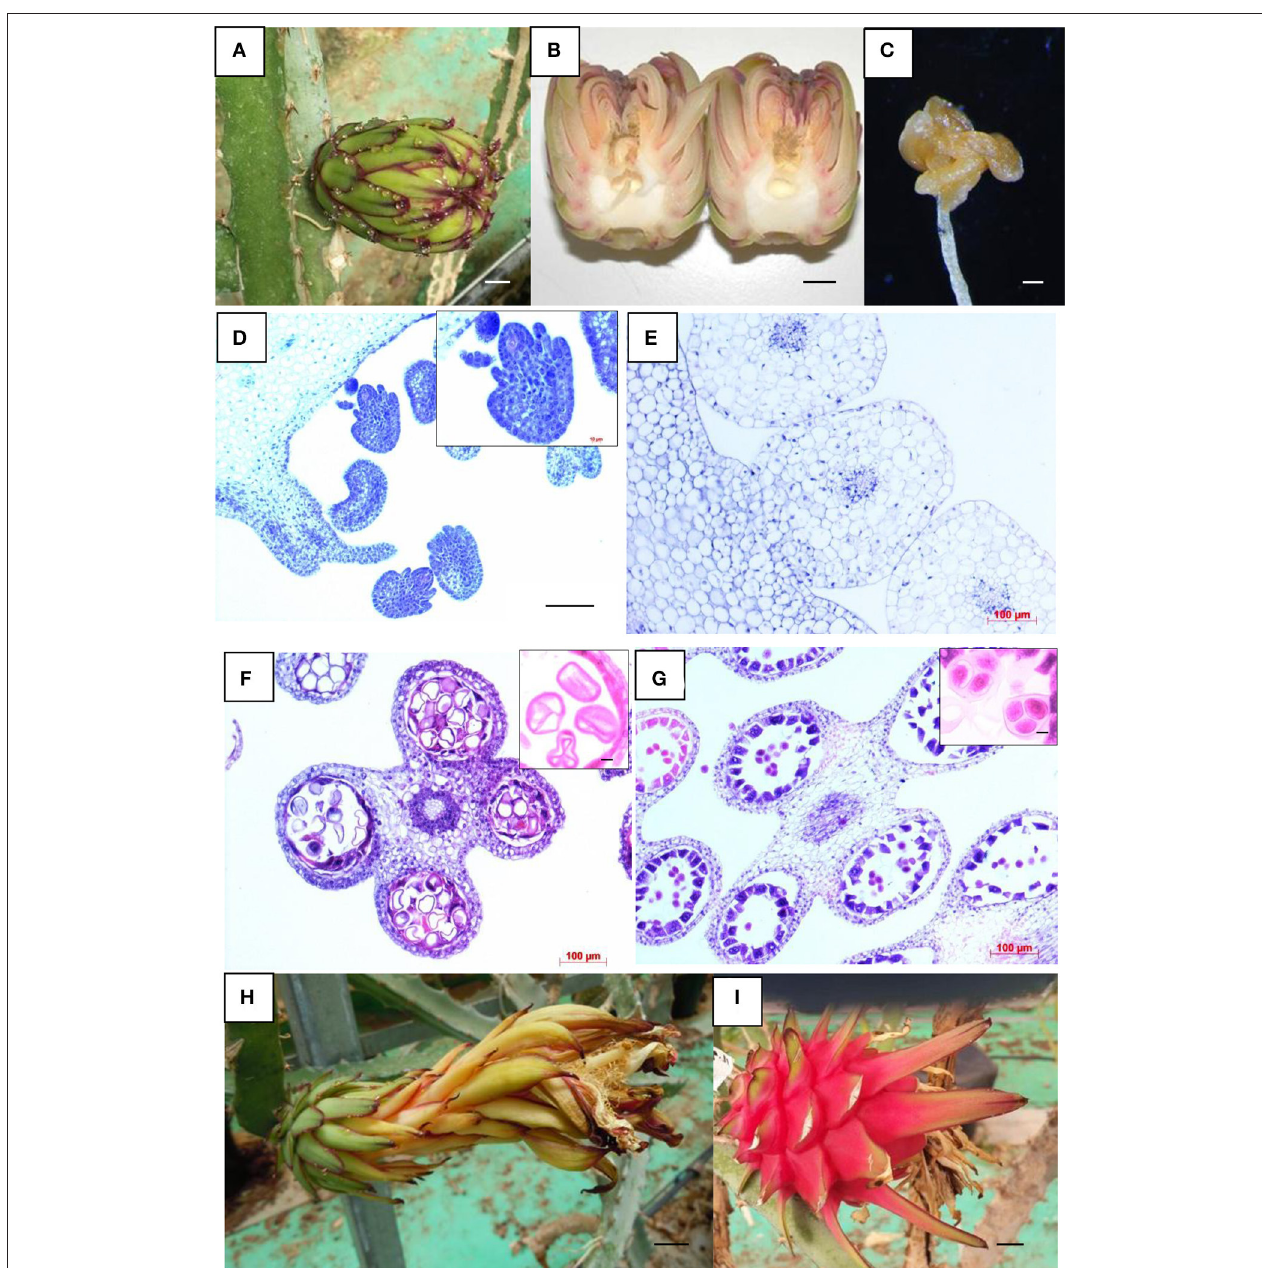
FIGURE 2 | Reproductive parts of the diploid donor H. monacanthus and androgenic H. monacanthus lines. (A) Flower bud from the androgenic line 007, showing an atypical folded end (scale bar 1cm). (B) Aborted open flower bud from the androgenic line 011 (scale bar 1cm). (C) Deformed anther detached from an aborted flower bud of androgenic line 011 (scale bar 200 µ m). (D–G) Histological sections of flower buds having the same length (6cm), as follows: (D) Androgenic line 007 showing abnormal ovules (scale bar 100 µ m), with a close-up of a shrunken ovule in the upper right-hand inset (scale bar 10 µ m), (E) Well-developed ovules of the diploid donor (scale bar 100 µ m), (F) Anther of the androgenic line 007 showing aborted tetrads, and a few uninucleate microspores with an atypical triangular shape (scale bar 100 µ m), with a close-up of aborted pollen grains in the upper right-hand inset (scale bar 10 µ m) (G) Anther of the diploid donor showing well-developed and viable tetrads (scale bar 100 µ m), with a close-up of viable grains in the upper right-hand inset (scale bar 10 µ m). (H) Anthesis in the androgenic line 011 (scale bar 1cm), and (I) Mature fruit from line 011 (scale bar 1cm).